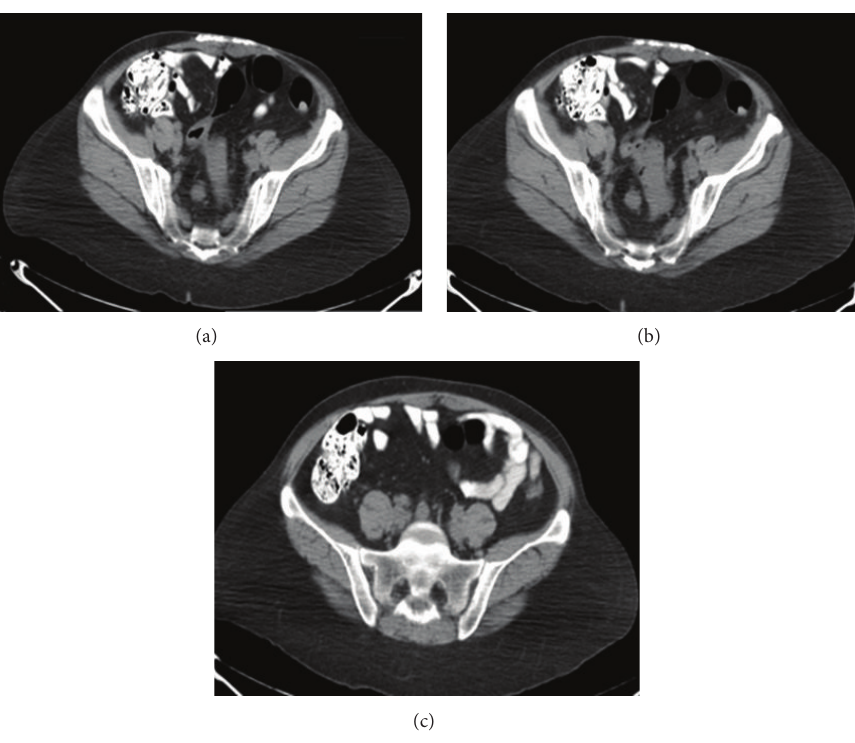
Figure 1: Computer tomography of the abdomen showing (a) an abnormal soft tissue density involving the sigmoid colon; (b) an enlarged lymph node right to the sigmoid colon; (c) multiple enlarged lymph nodes just below the bifurcation of the abdominal aorta into the common iliac arteries.